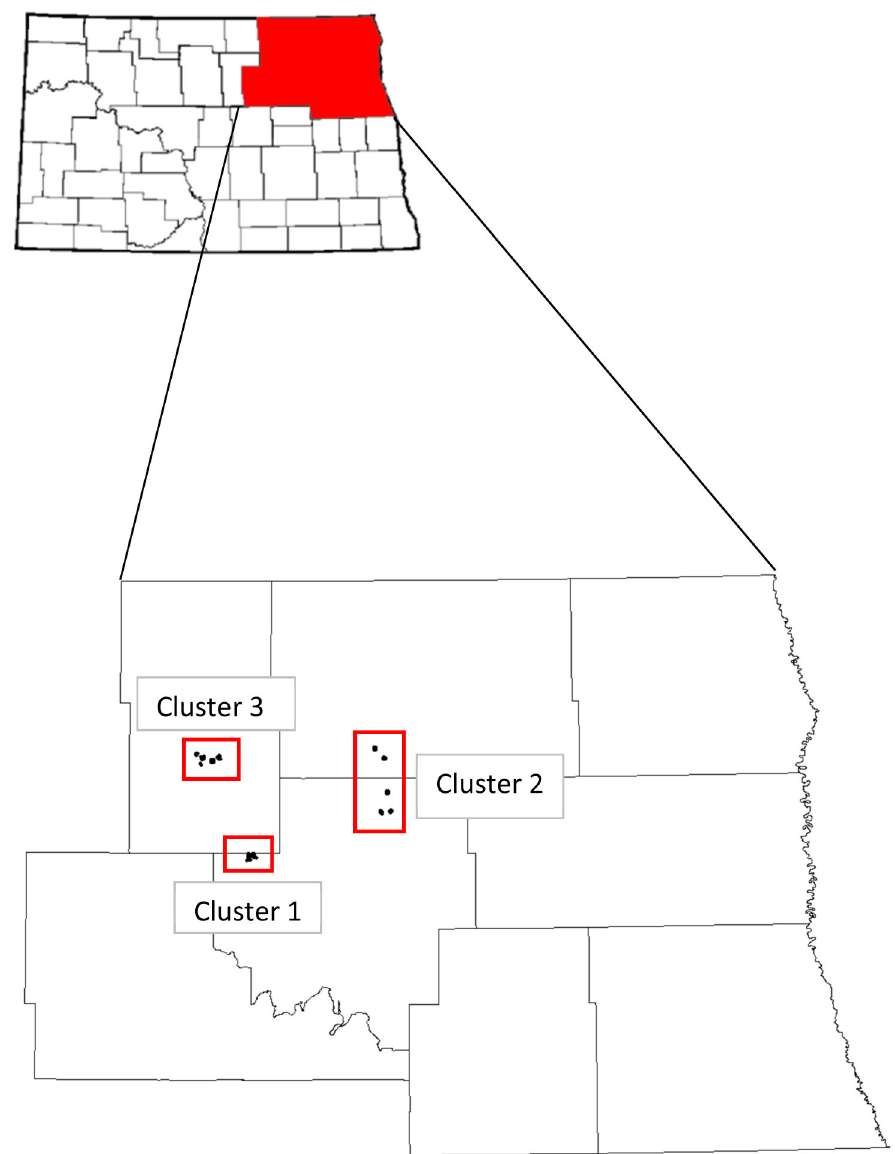
Figure 1. Map of study area. Map of study sites divided into clusters in the Devils Lake Wetland Management District, North